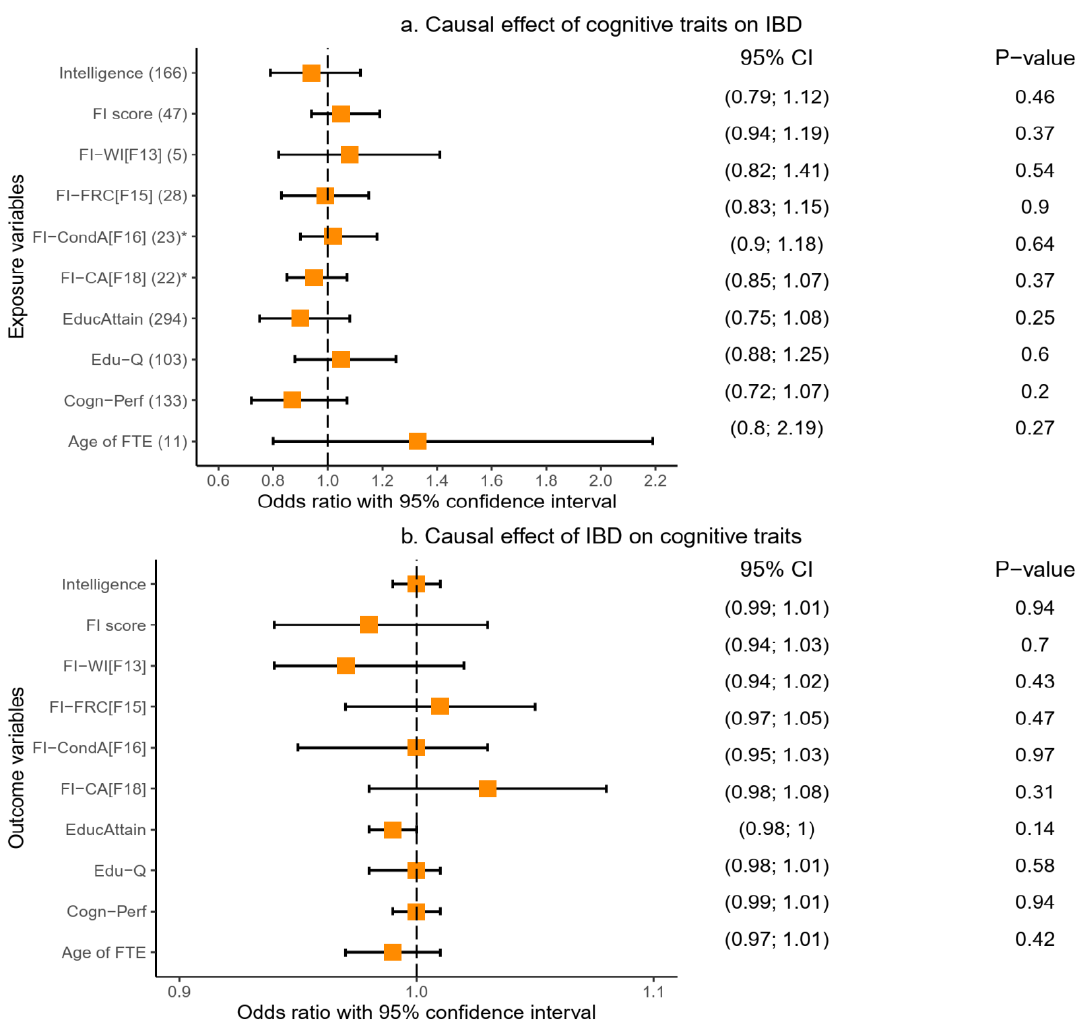
Figure 6. Causal relationship between cognitive traits and IBD based on the IVW MR model. IBD: inflammatory bowel disease, Age of FTE: age completed full-time education, FI-CA[F18]: fluid intelligence-chained arithmetic, FI-CondA[F16]: fluid intelligence-conditional arithmetic, FI-FRC[F15]: fluid intelligence-family relationship calculation, FI-WI[F13]: fluid intelligence-word interpolation, Cogn-Perf: cognitive performance, EducAttain: educational attainment, *instrumental variables selected at P snp < 1 × 10 −5 , ivw: inverse variance weighted, MR: Mendelian randomisation. Table 6. Results of bidirectional MR-PRESSO analysis for IBD and cognitive traits. 414 MR-Egger MR-PRESSO RESULTS Intercept Exposure (nSNPs) Outcome Global Raw Cor- Inter- P P P test P OR OR cept Cognitive traits (exposure) and IBD (outcome) Age of fulltime educa-